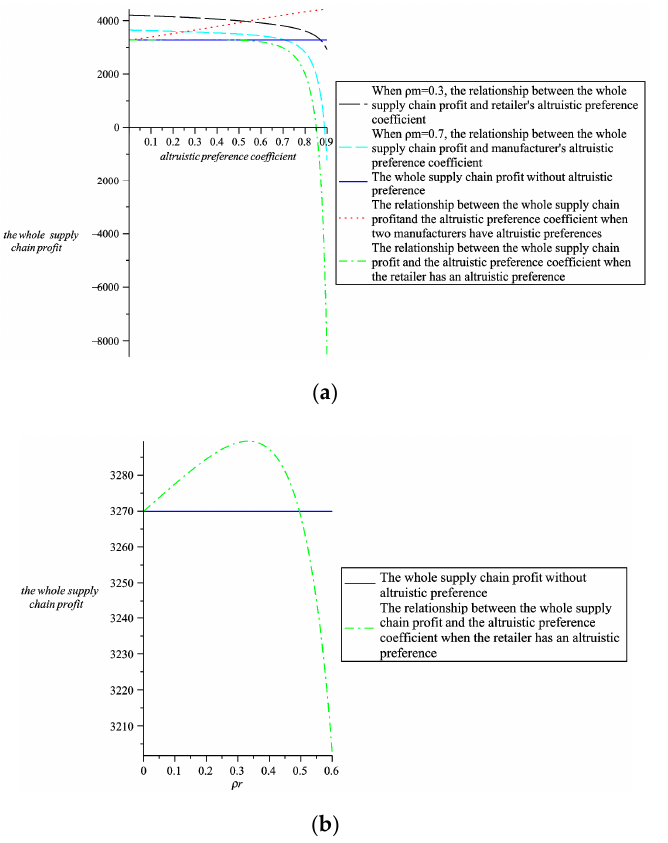
Figure 10. The relationship between the whole supply chain profit and altruistic preference coefficients. ( a ) The relationship between the whole supply chain profit and altruistic preference coefficients in four models. ( b )The relationship between the whole supply chain profit and altruistic preference coefficients when the retailer has altruistic preferences and when there are no altruistic